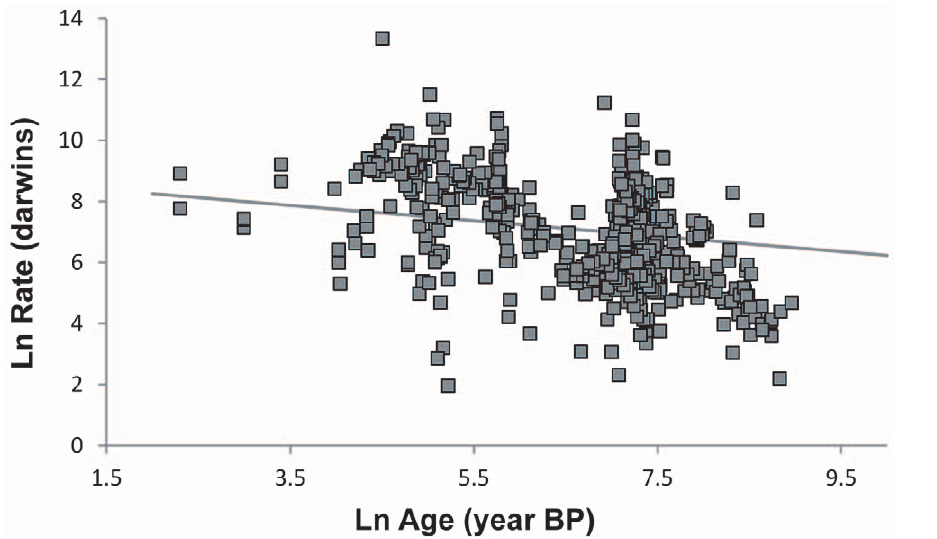
Figure 3. Rates of cultural evolution are inversely correlated with their age. The age of a rate corresponds to the midpoint, in years Before Present (BP), of the time interval over which the rate is calculated. The solid line represents the linear mixed model of interaction of rates with age (Table 3).